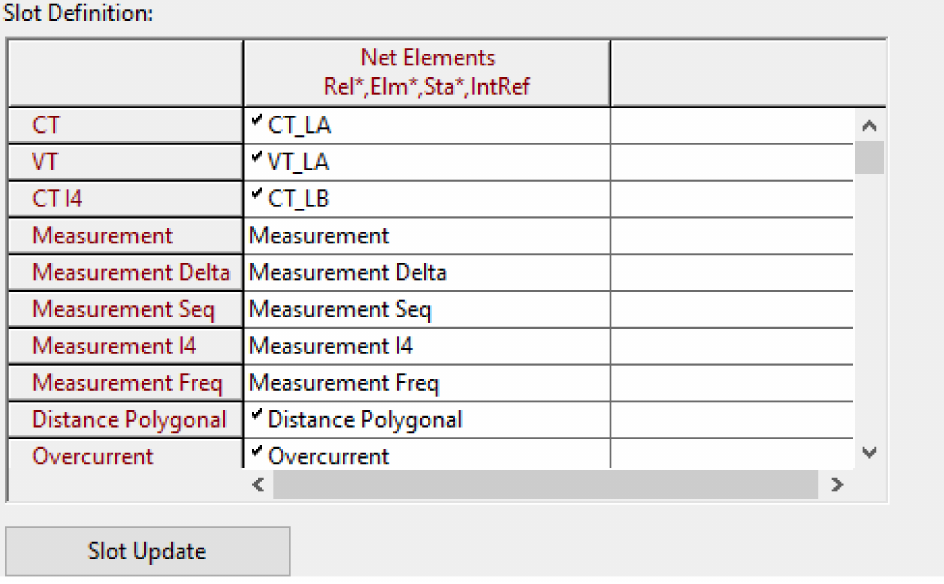
Figure 12. Slot definitions in protection relay with mutual coupling CT_L2 included.